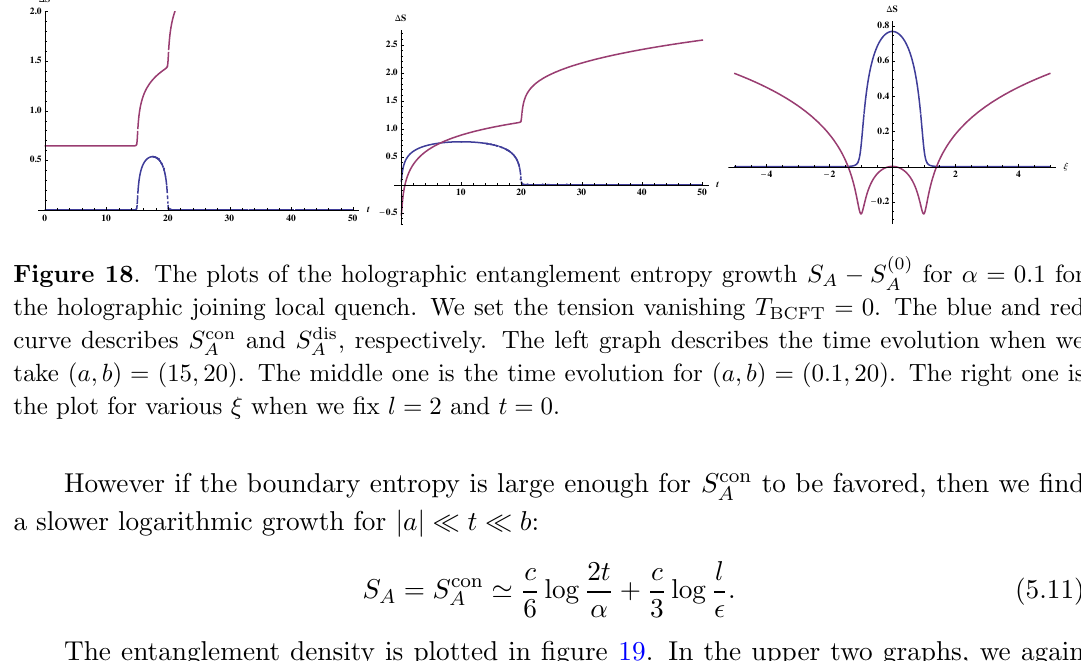
for (cid:11) = 0 : 1 for A